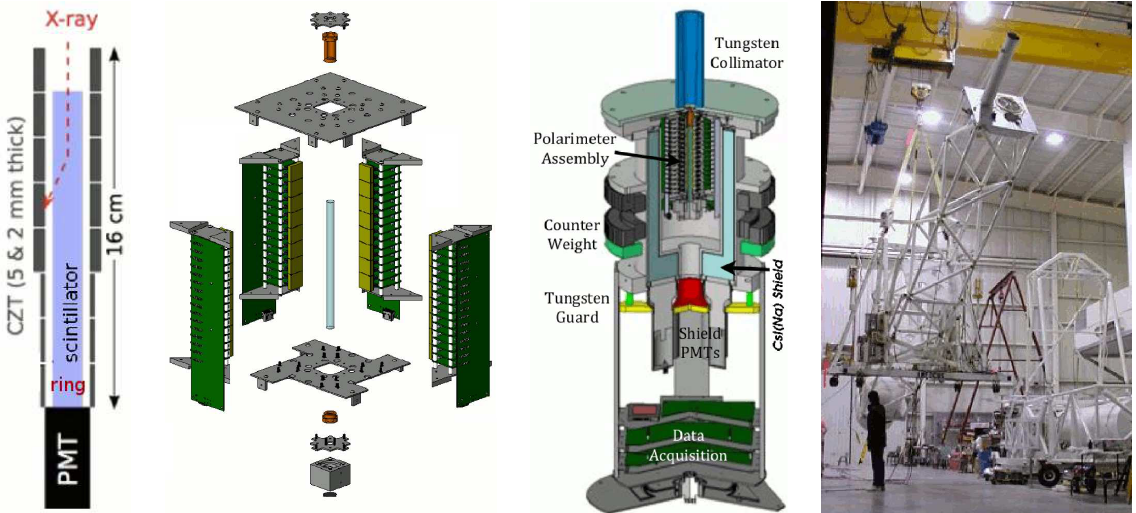
Figure 1: Left: Incoming X-rays are Compton-scattered (scintillator rod, optical axis) and subsequently photo- absorbed in one of the surrounding CZT detectors. Middle left: ’Exploded’ view of the polarimeter: four sides of detector columns surround the central scintillator rod. Middle right: Polarimeter with CsI shield, electronic readout and azimuthal rotation bearing. Right: The InFOCuS balloon gondola. measured by Integral. The CZT Imager on Astrosat ( http://astrosat.iucaa.in/ ) is expected to be used for polarization measurements in the 150 − 250 keV